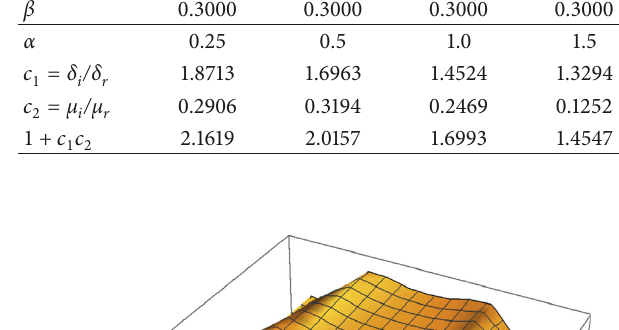
and c of the GLE 1 2